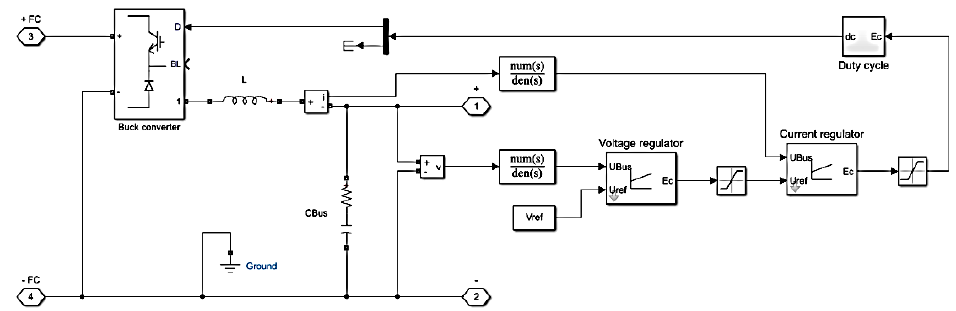
Figure 8. Circuit schematic for converter model simulation. Table 6. Converter model parameters.